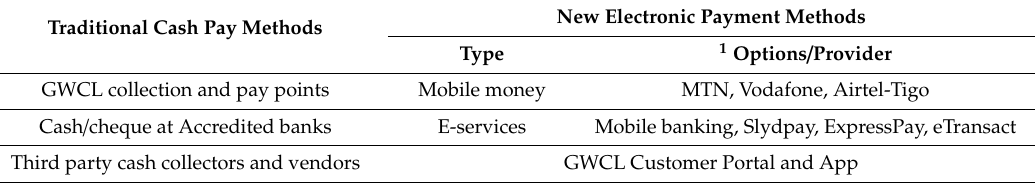
Table 1. Traditional and new electronic water payment methods in